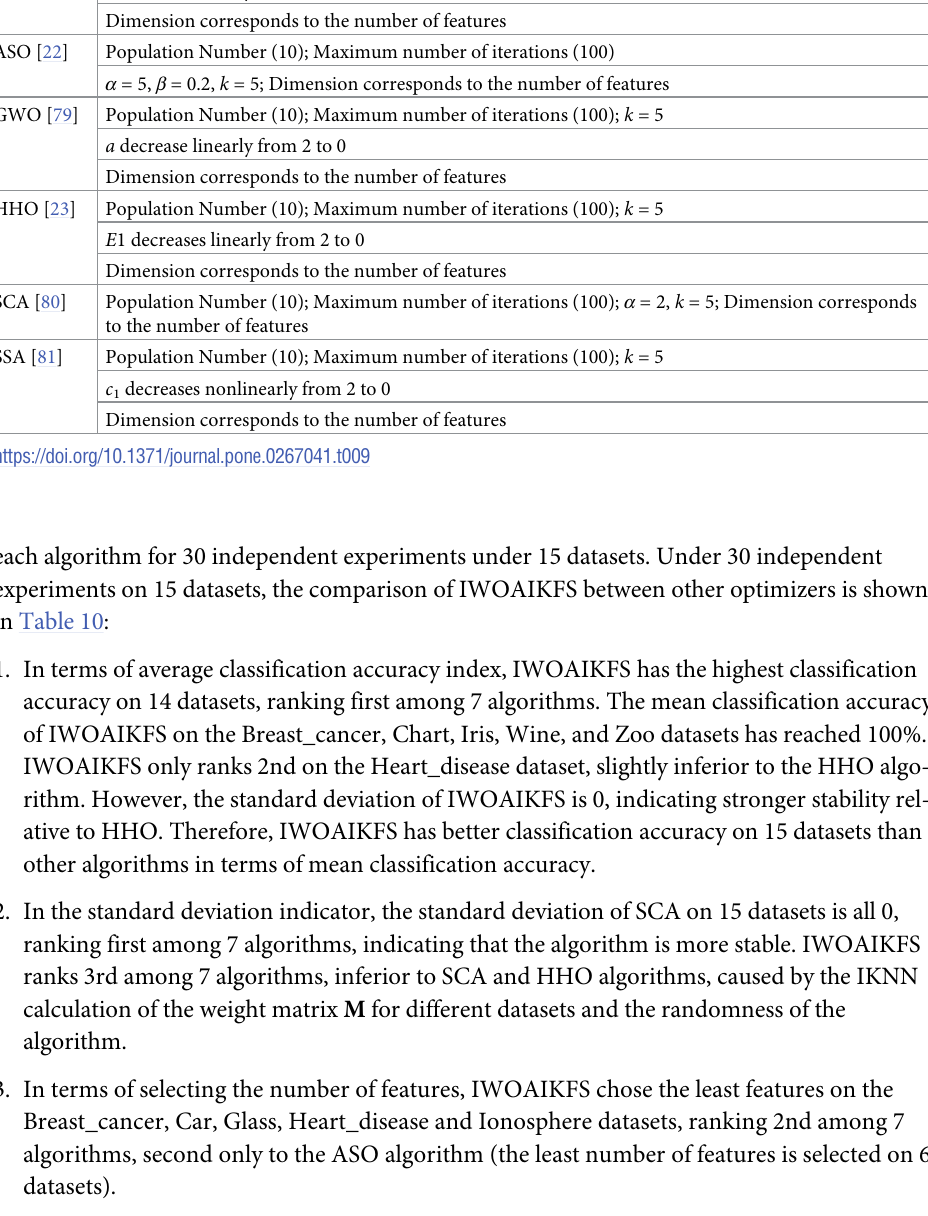
Table 9. Parameter settings of IWOAIKFS and other selected algorithms. Algorithms Parameters